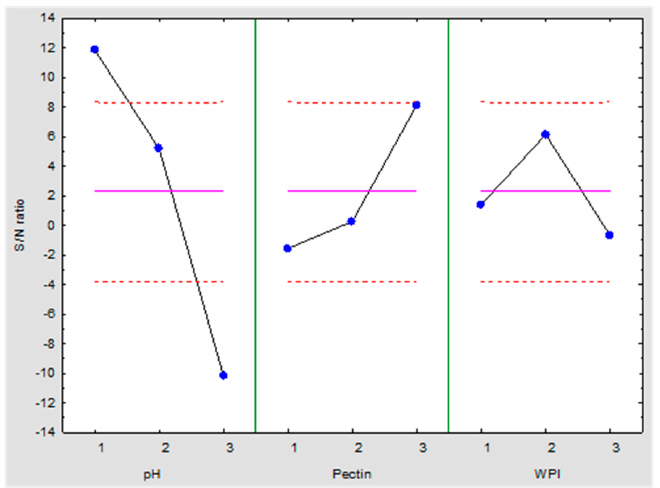
Figure 1. Individual factor performance at different levels. Dashed lines indicate ± 2 standard error, and S/N indicates signal-to-noise ratio.